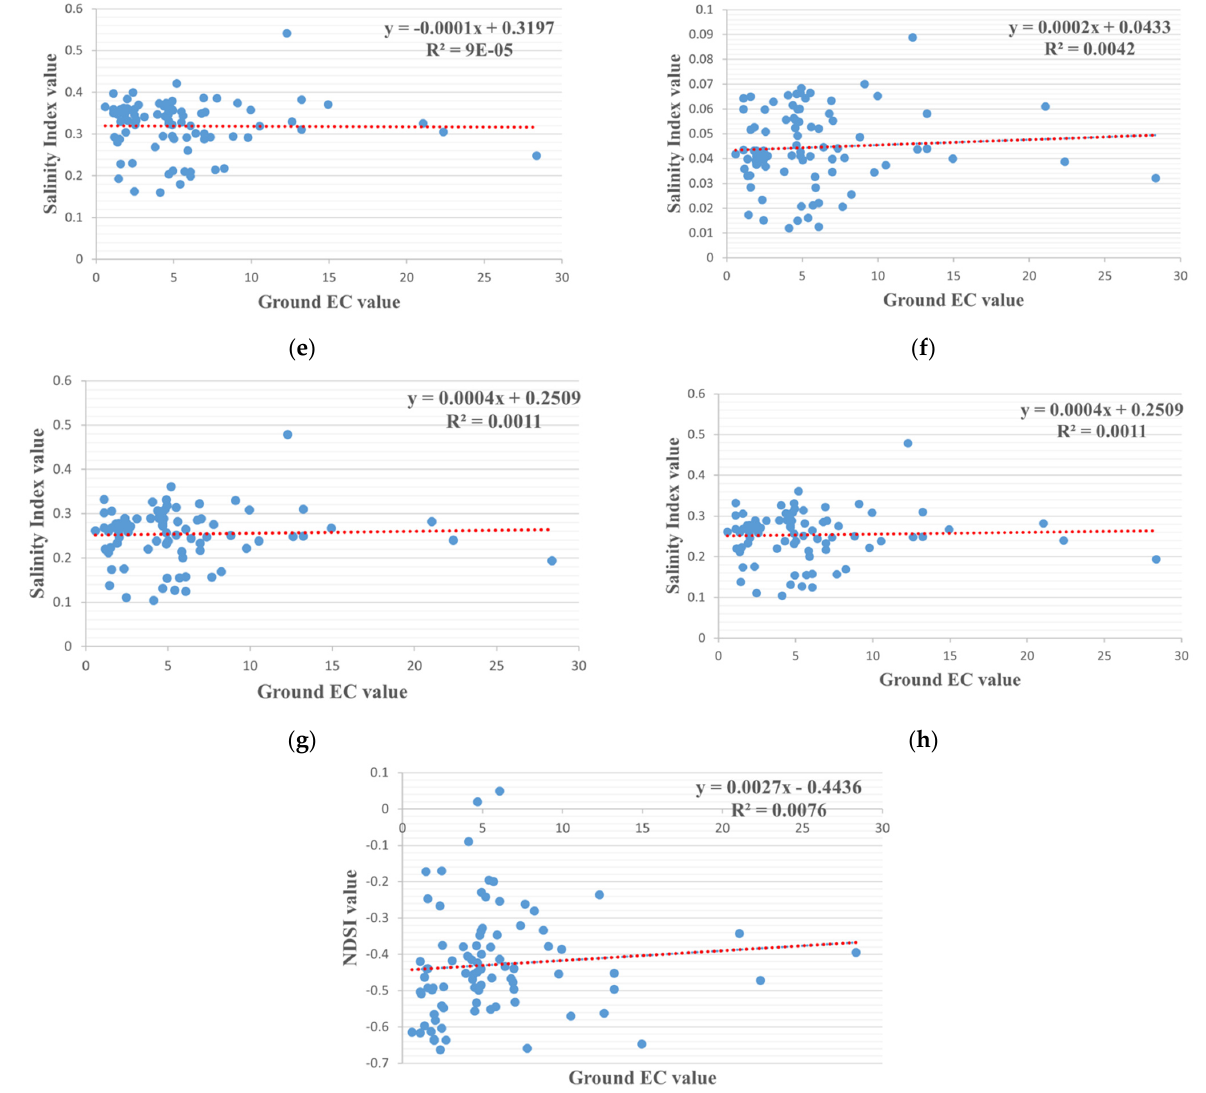
Figure 7. ( a ) Linear Regression between ground EC and Salinity Index 1; ( b ) Linear Regression between Ground EC value and Salinity Index 2; ( c ) Linear Regression between ground EC value and Salinity Index 3; ( d ) Linear Regression between Ground EC value and Salinity Index 4; ( e ) Linear Regression between value Ground EC value and Salinity Index 5; ( f ) Linear Regression between Ground EC value and Salinity Index 6; ( g ) Linear Regression between Ground EC value and Salinity Index 7; ( h ) Linear Regression between ground EC value and Salinity Index 8; ( i ) Linear Regression between Ground EC value and NDSI.